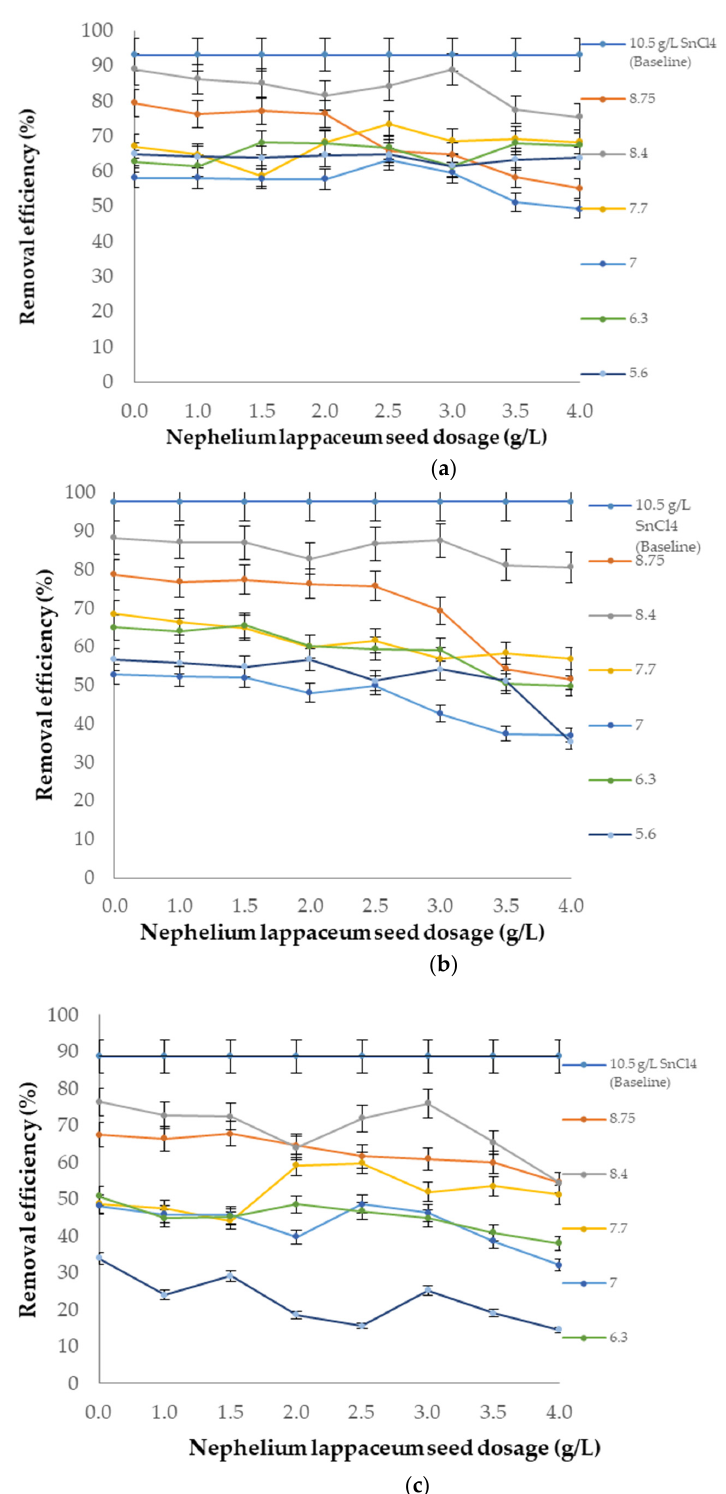
Figure 10. Removal efficiencies of pollutants at pH 7 with varied dosages of SnCl 4 as coagulant and Nephelium lappaceum seed as a flocculant. ( a ) Colour; ( b ) Suspended solids (SS); ( c ) COD.